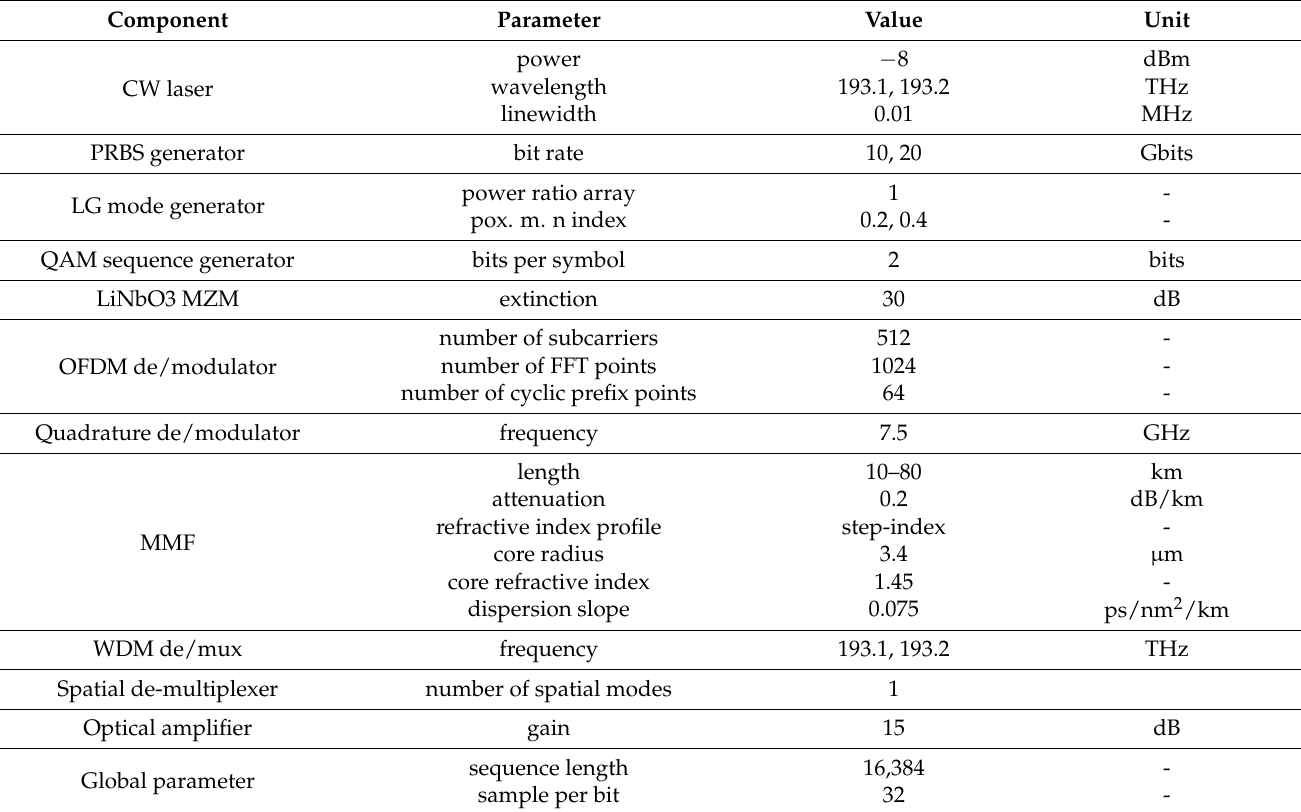
Table 1. The Main Parameters of the OAM-DM-WDM-OFDM-PON System.